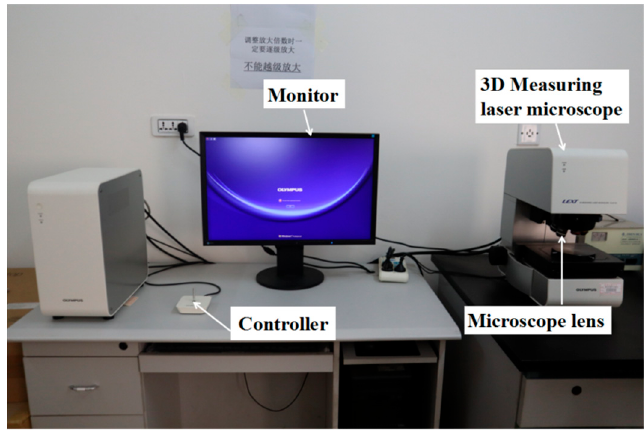
Figure 8. Microscopic experimental setup.